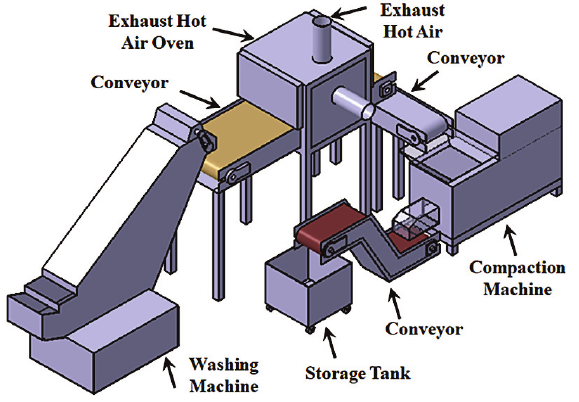
Fig. 5. Set up design for exhaust hot air utilization.